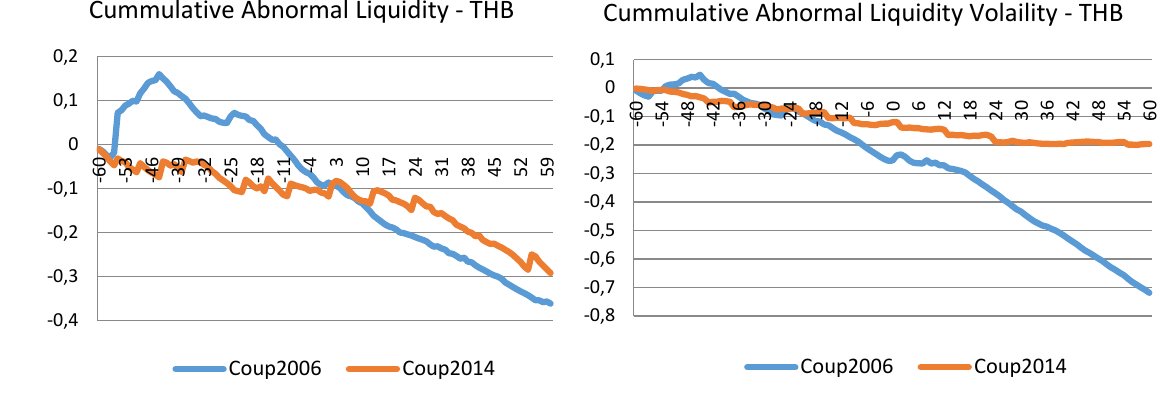
Figure 5. Cumulative abnormal market quality in the Thai currency market Table 3. Short-run analysis on the